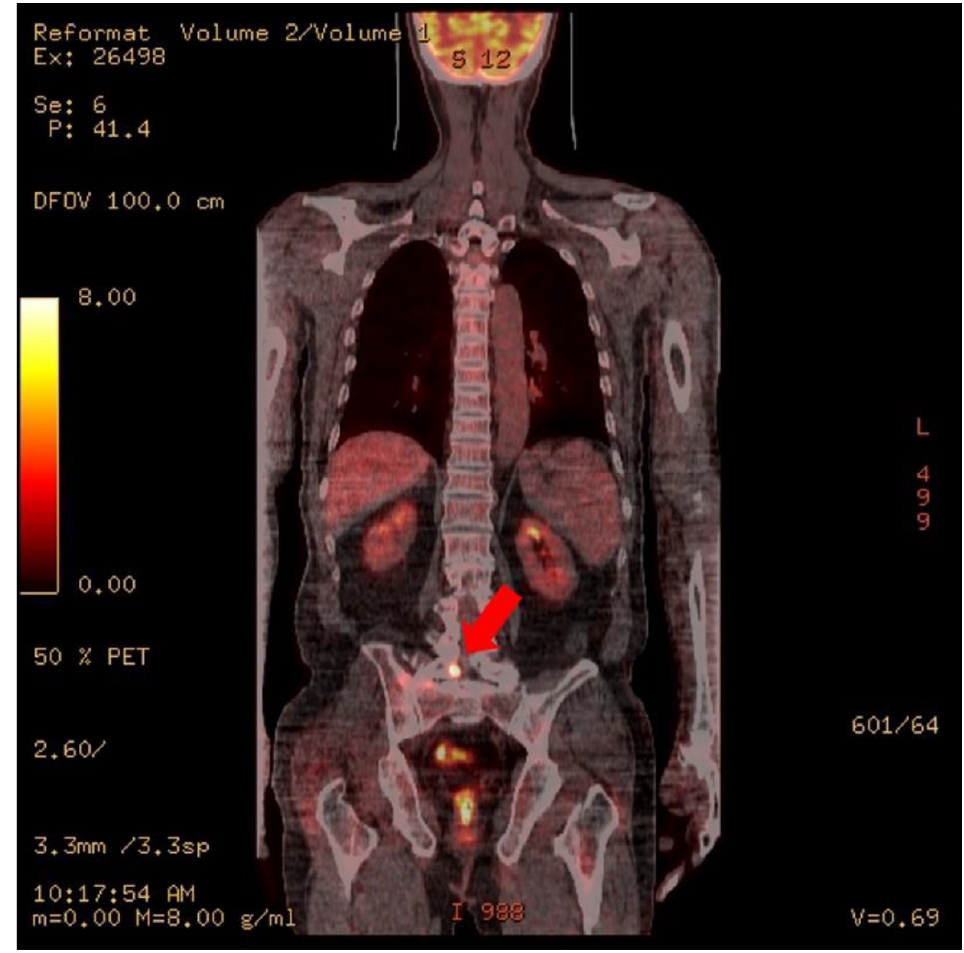
Figure 2. PET CT. Focal increased uptake is noted at right L5, the sacrum, and the presacral area (arrows).